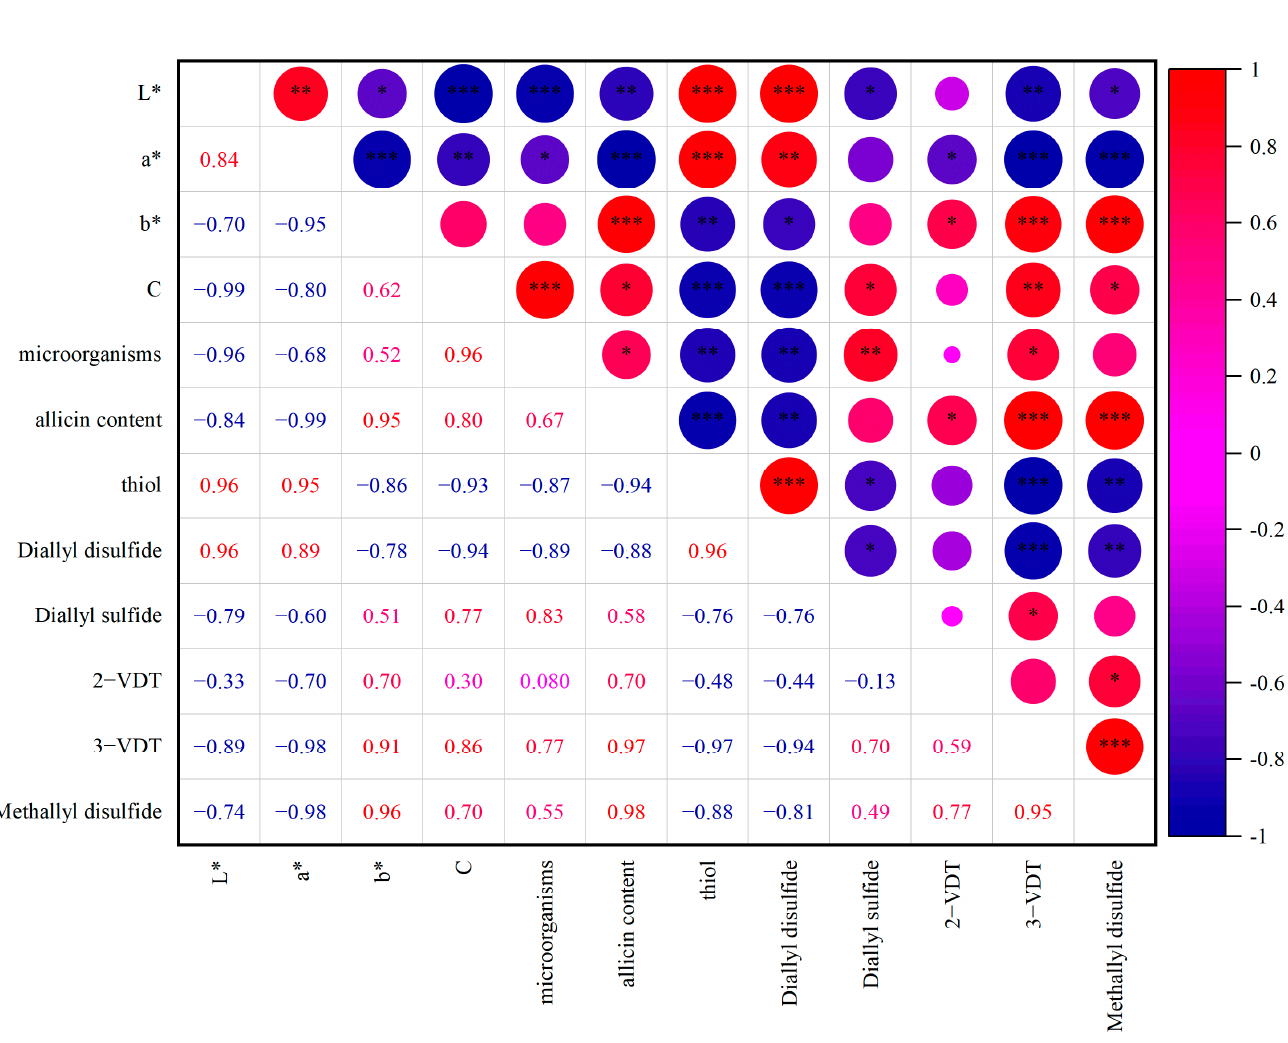
Figure 6. Correlation analysis of color indexes and quality-related attributes. * indicates 0.01 < p ≤ 0.05, ** indicates 0.001 < p ≤ 0.01, *** indicates p ≤ 0.001, respectively.